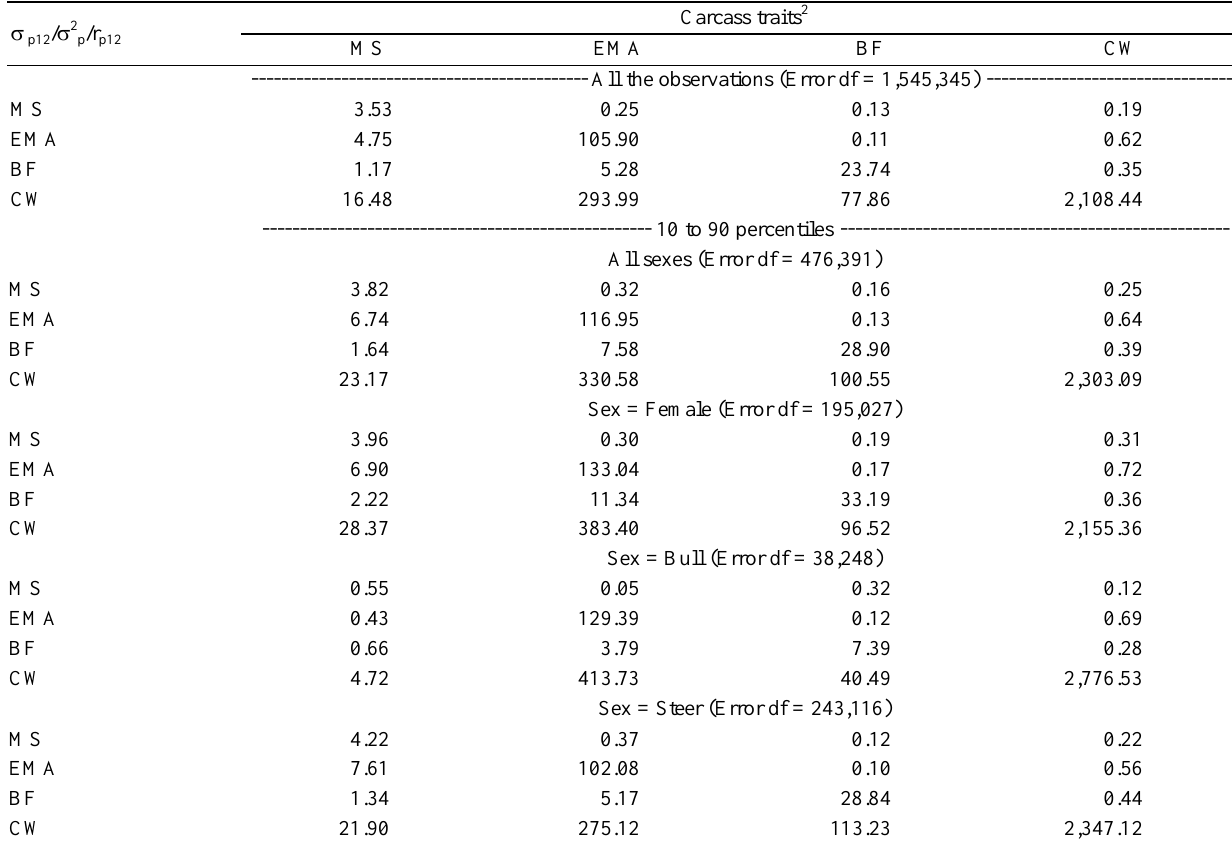
Table 3. Phenotypic variances (  2 p , diagonals), covariances (  p12 , below diagonals) and correlation coefficients (r p12 , above diagonals) estimated between carcass traits